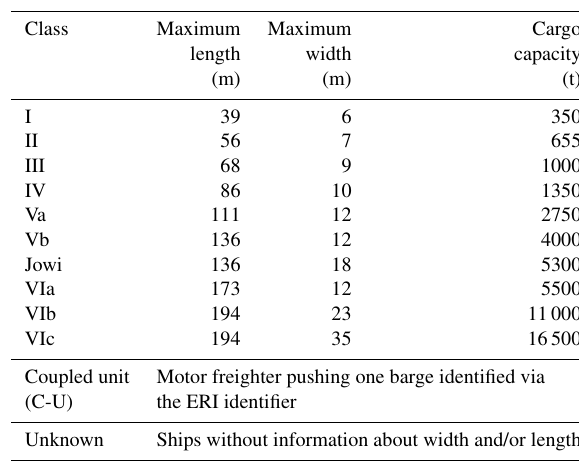
Table 3. Modified ship classification scheme based on CEMT (Eu- ropean Conference of Ministers of Transport, 1992) classes. Ships are categorised by their respective length and width; e.g., a ship longer than 86m but shorter than 111m and width between 10 and 12m is classified as class Va. Additionally, coupled units are identi- fied via their Electronic Reporting International (ERI) code, which is also transmitted in the AIS